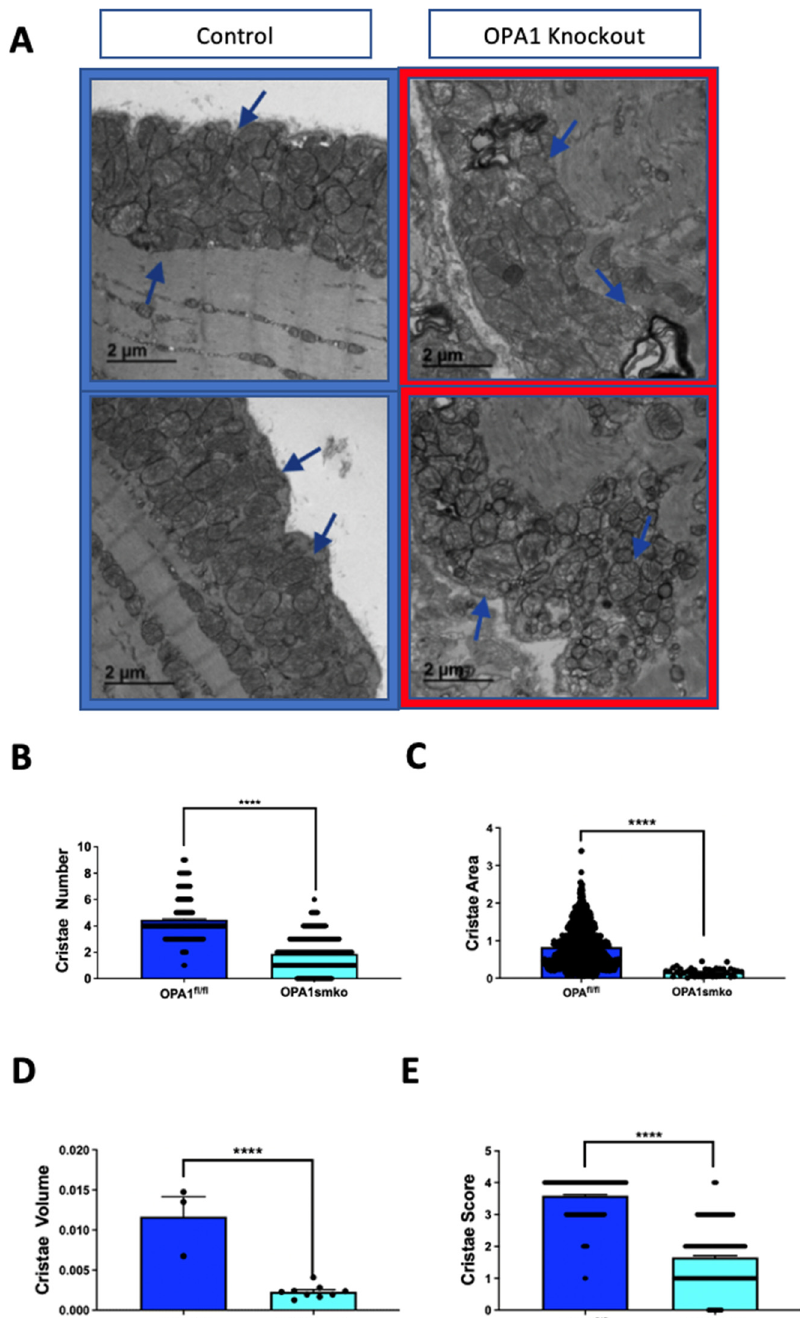
Figure 4. Knockdown of OPA1 disrupts cristae structure. ( A ) Representative TEM images of cristae in mouse skeletal muscle tissue from OPA1 knockdown (red outline) and control (blue outline) tissue. ( B ) Quantification of cristae number, ( C ) cristae area, ( D ) cristae volume, and ( E ) cristae score. Statistical significance is indicated by asterisks; **** indicate p ≤ 0.0001.